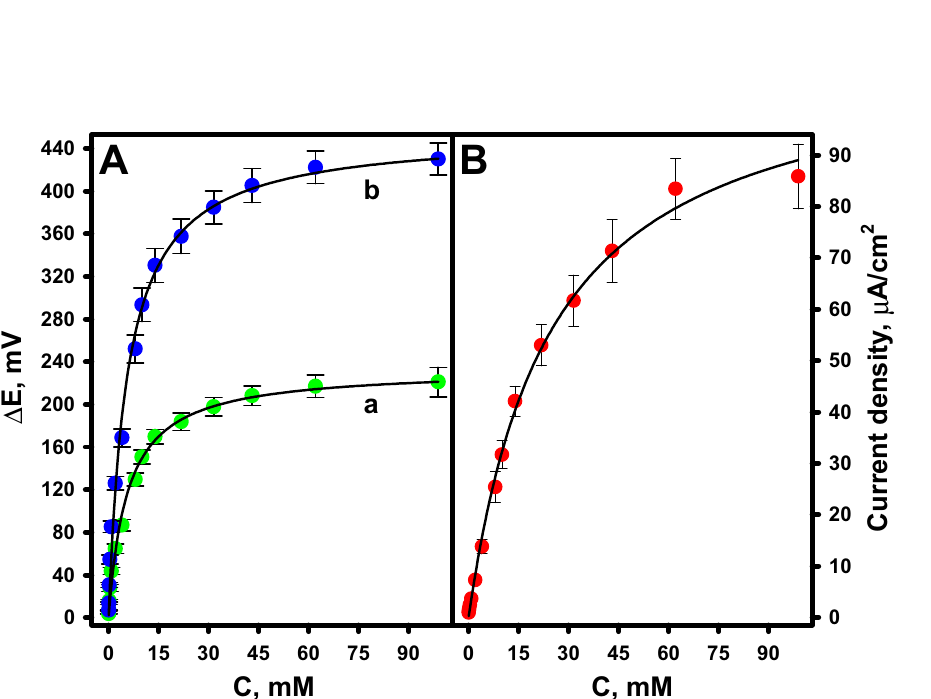
Figure 6. Dependence of potential ( A ) and current density ( B ) at open-circuit (curve b) and at an external load of 476 kΩ (curve a) generated by the biocathode on glucose concentration. Measurements conditions: A-PBS- KCl, pH 6.0, applied potential of + 0.1 V for amperometric